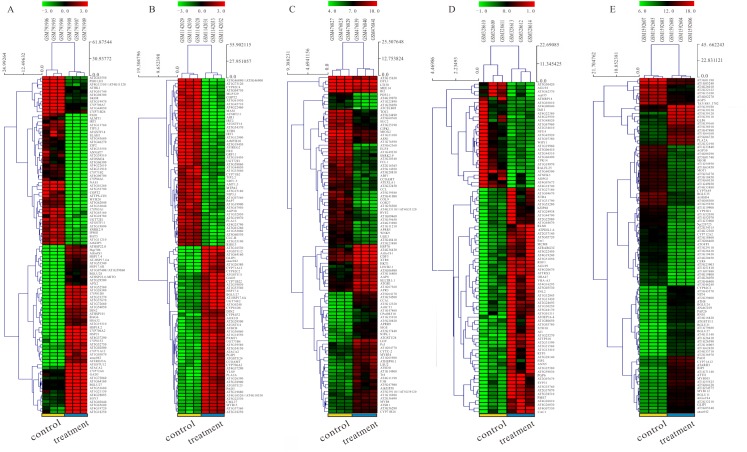
Hierarchial clustering heatmap image of DEGs screened on the basis of |fold change |> 2.0, P-value < 0.05.(A) GSE31977 data (As treatment), (B) GSE46958 data (Au treatment), (C) GSE19245 data (Cd treatment), (D) GSE13114 data (Cu treatment), (E) GSE65333 data (Pb treatment).